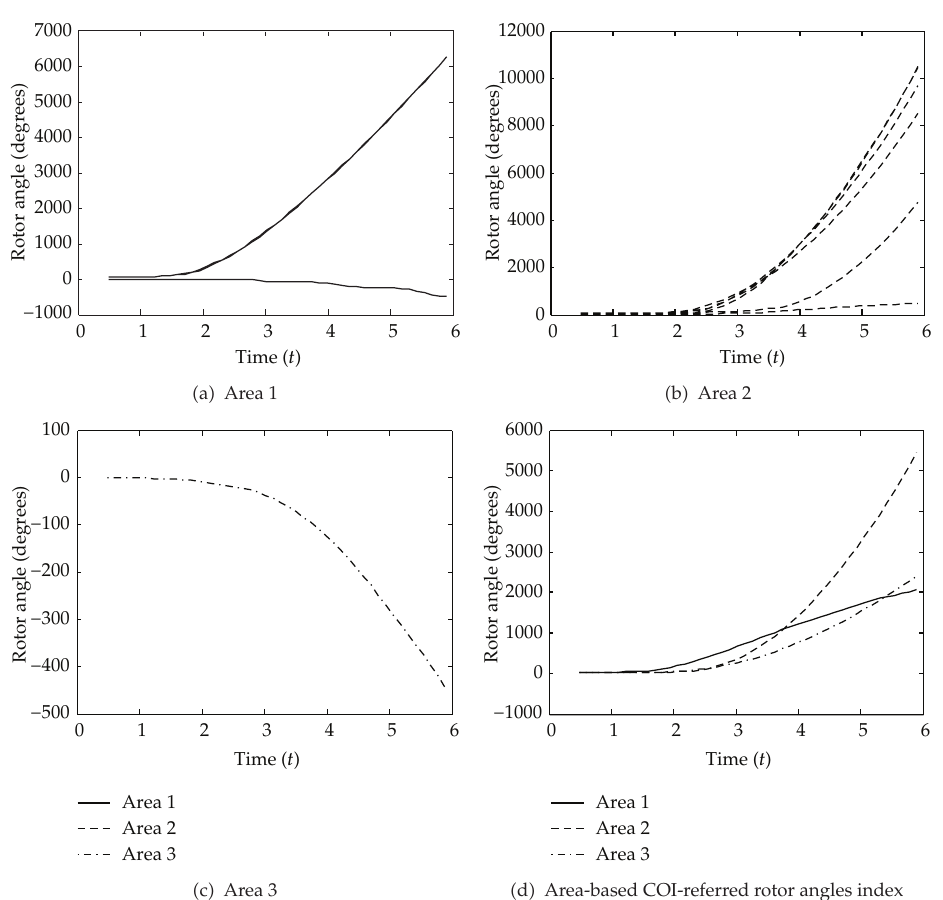
Figure 2: Case 1: The system becomes unstable due to a fault at Line 4 (cid:5) Area 1 (cid:6) .